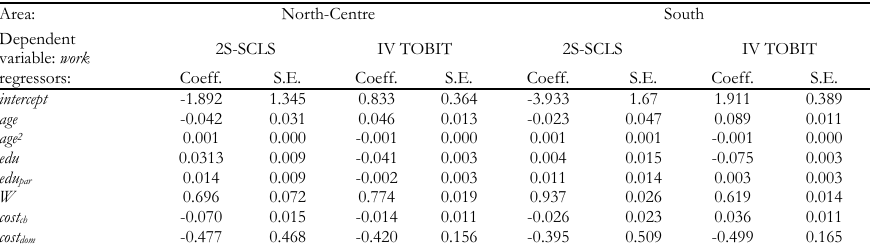
The female paid-work equation estimation for geographical